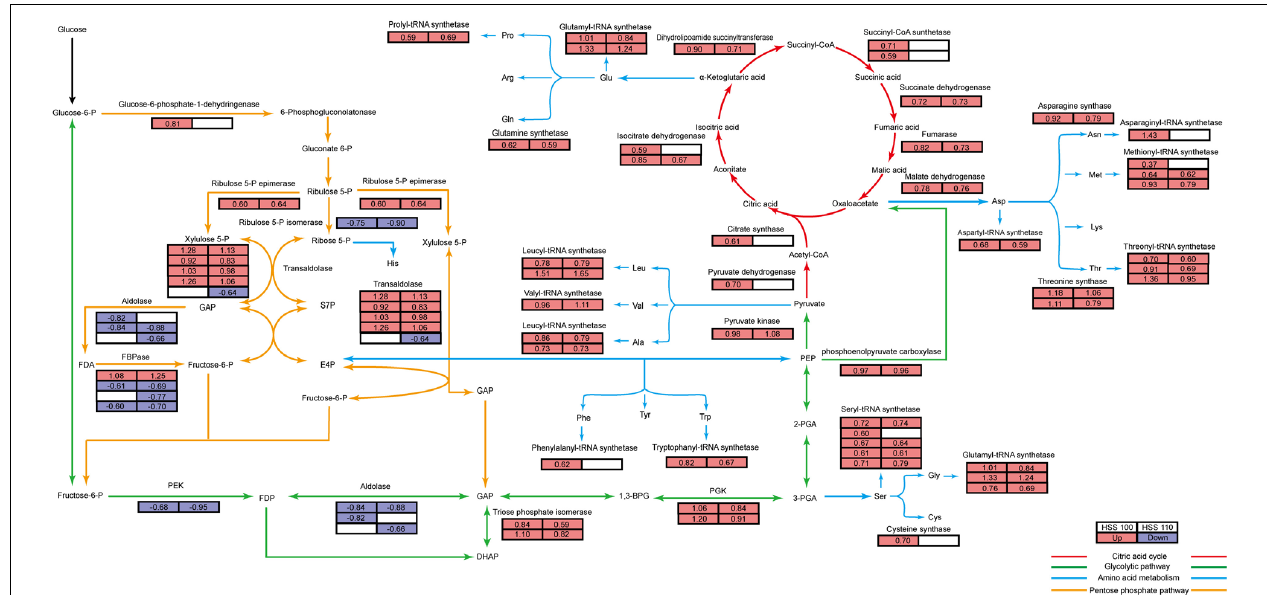
FIGURE 7 | Energy metabolism map of P. haitanensis under hypersaline stress. Green lines represent the glycolytic pathway (i.e., EMP pathway), yellow lines represent the pentose phosphate pathway, red lines represent the TCA cycle, and blue lines represent the amino acid and aminoacyl-tRNA synthesis pathway. The tables on the left and right represent the HSS 100 and 110 conditions, respectively, and the colors reflect the protein content differences relative to the abundance under normal conditions. Red, blue, and white correspond to increased, decreased, and unchanged, respectively. Numbers represent log 2 fold change (FC) values. FC ≥ 1.5 and P <